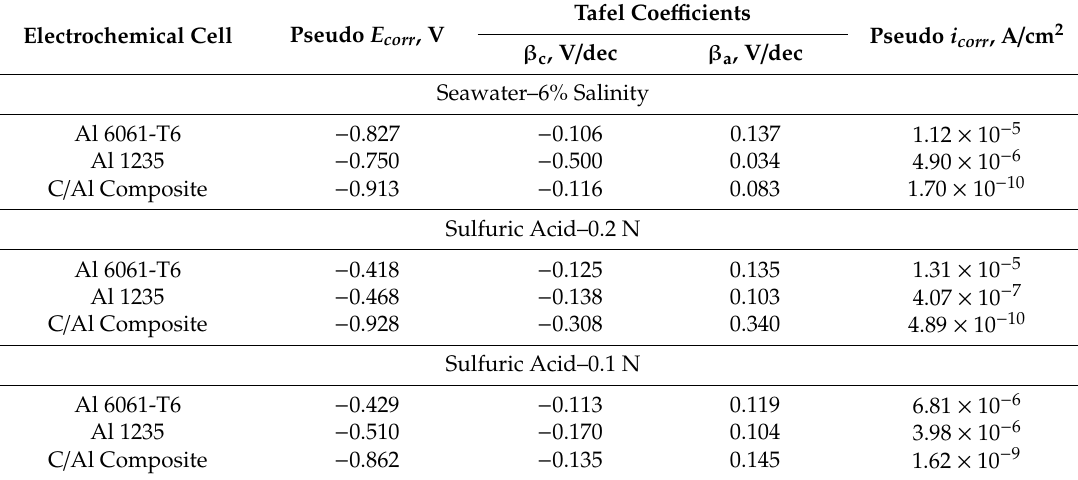
Table 1. Quantitative results from electrochemical analysis and dynamic